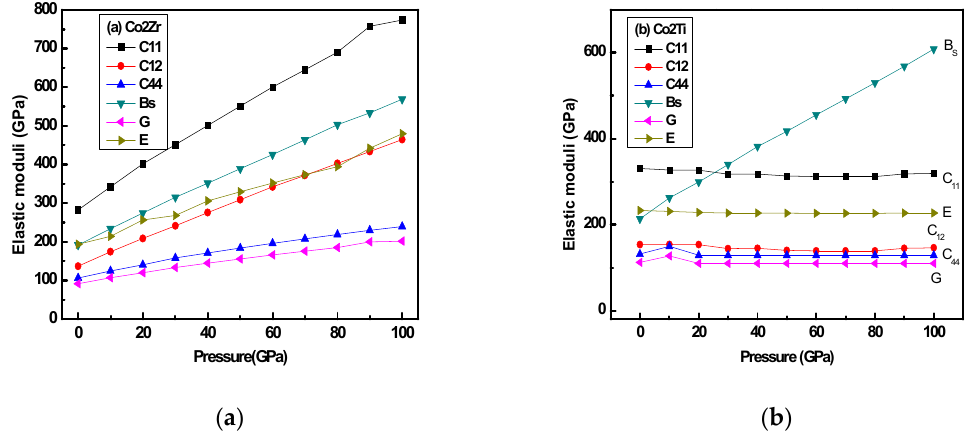
Figure 1. The C ij , E, G and B s of ( a ) Co 2 Zr and ( b ) Co 2 Ti versus pressure at 0 K.